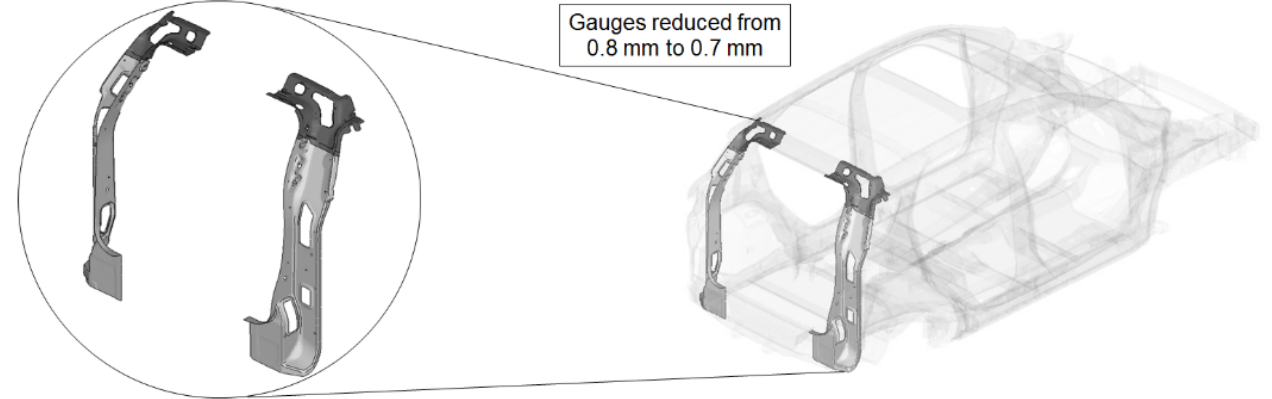
Figure 12. Optimized adjusted FE model of the vehicle body structure highlighting the parts with gauge reduction.